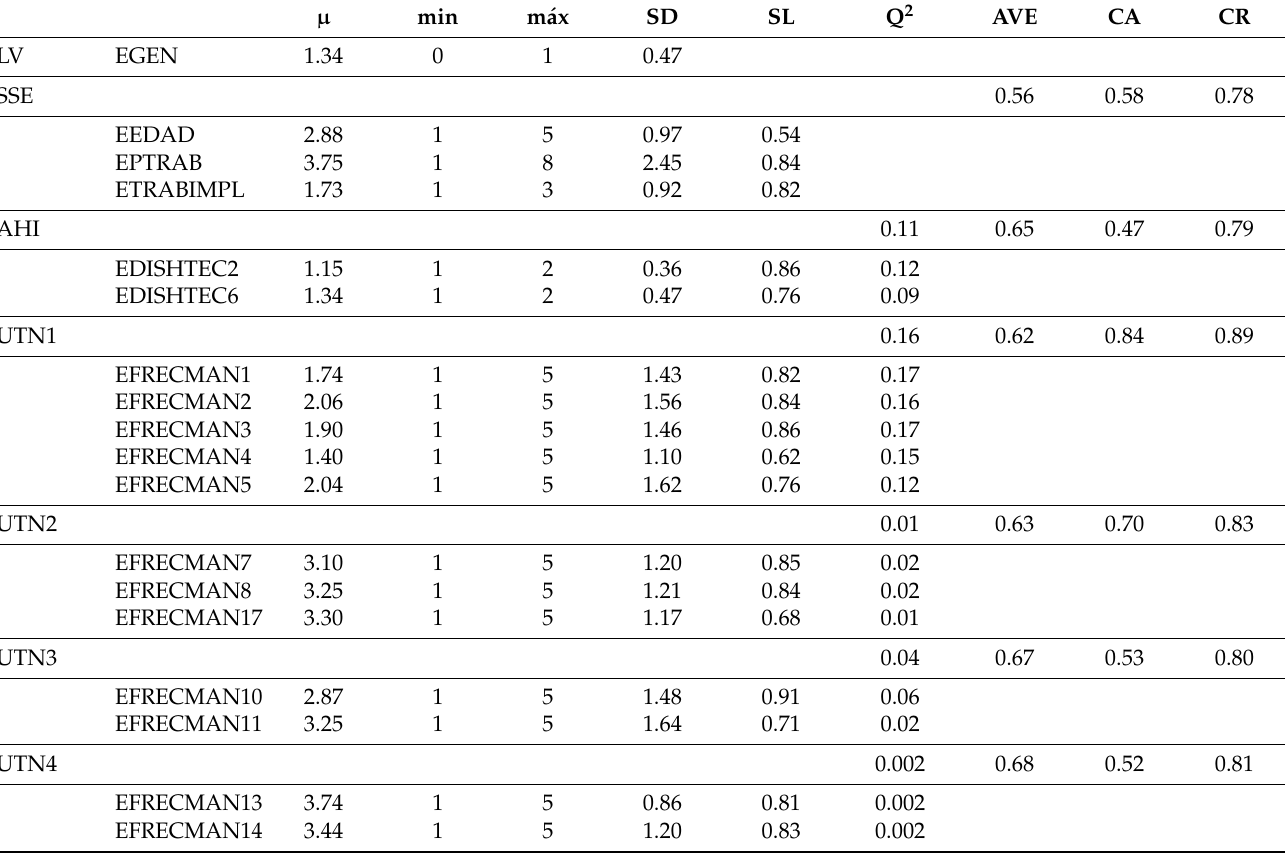
Table 3. Descriptive statistics of the model.